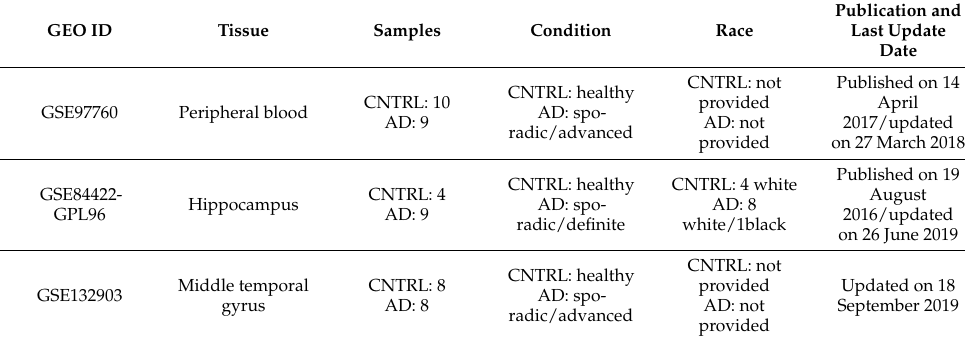
Table 1. Selected database